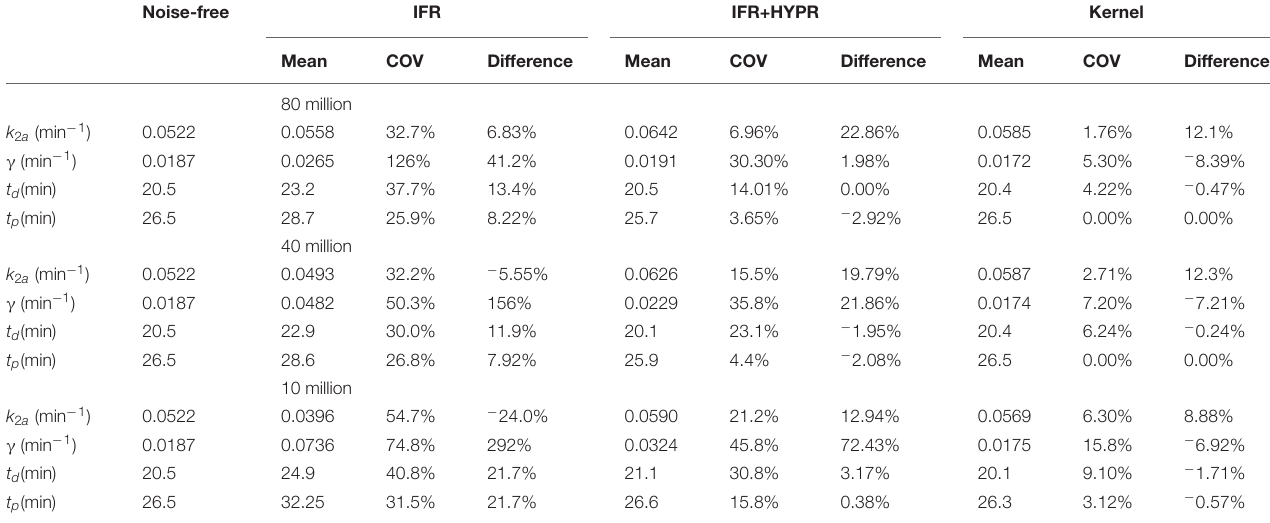
TABLE 2 | Pixel-wise lp-ntPET kinetic modeling k 2 a , γ , t d and t p mean, coefficient of variation (COV), and difference with respect to noise-free value, for independent frame reconstruction (IFR), independent frame reconstruction with HYPR denoising (IFR+HYPR), and spatiotemporal kernel reconstructions (Kernel), in simulations with 80, 40 and 10 million